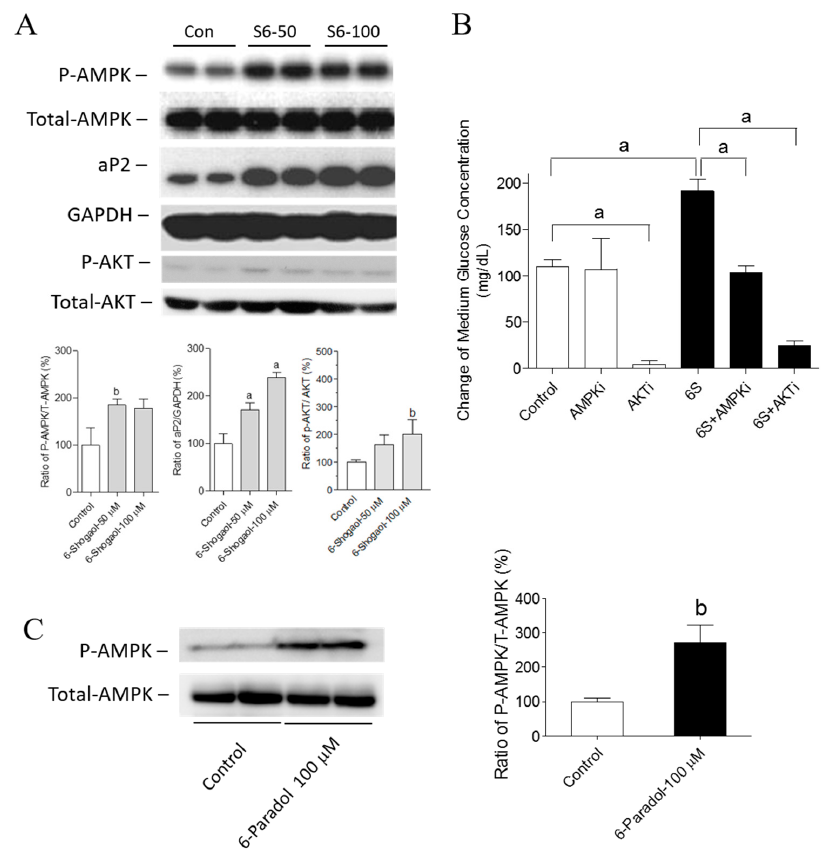
Figure 5. The effects of 6-shogaol on AKT and AMPK phosphorylation and aP2 protein expression and of 6-paradol on AMPK phosphorylation. ( A ) Differentiated 3T3-L1 adipocytes were treated